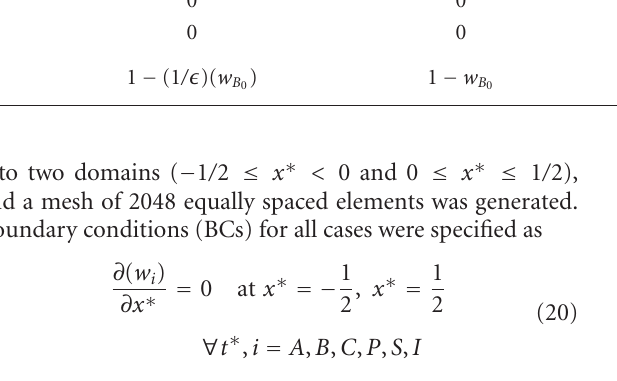
Table 4: Stoichiometric initial conditions based on w B